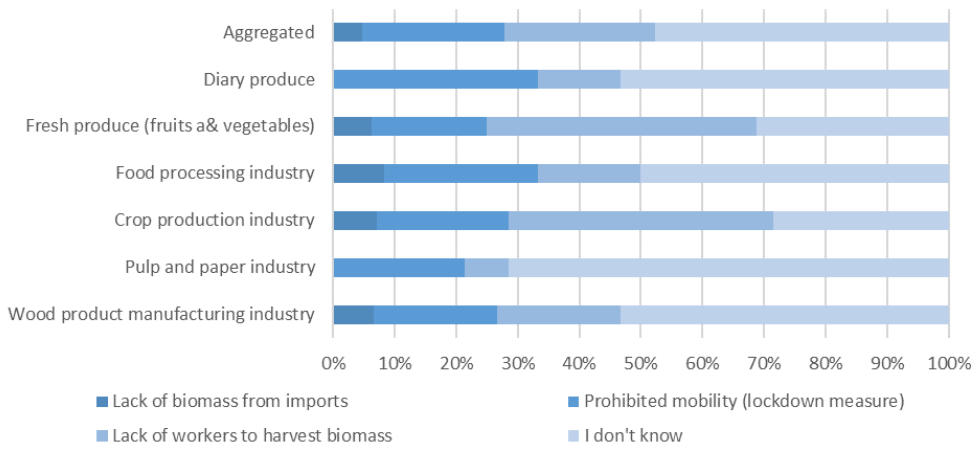
Figure A2. Reasons for negative disturbances on biomass supply chains from supply side reported by experts.